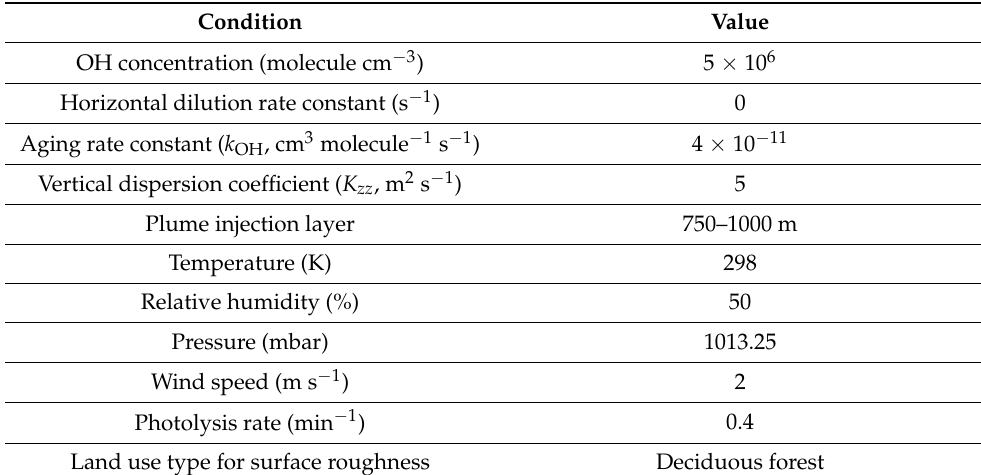
Table 1. Conditions and plume parameters for the base case.